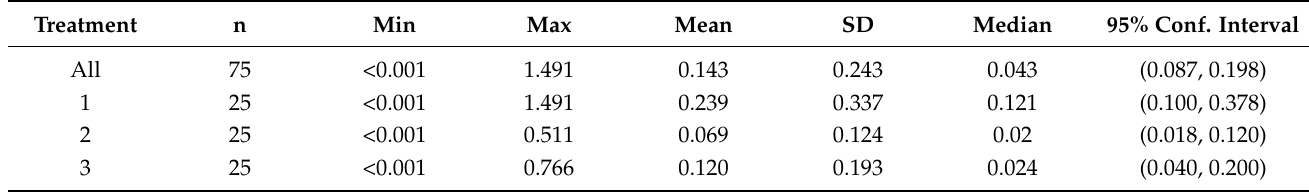
Table 1. Descriptive statistics for residual adhesive volume.